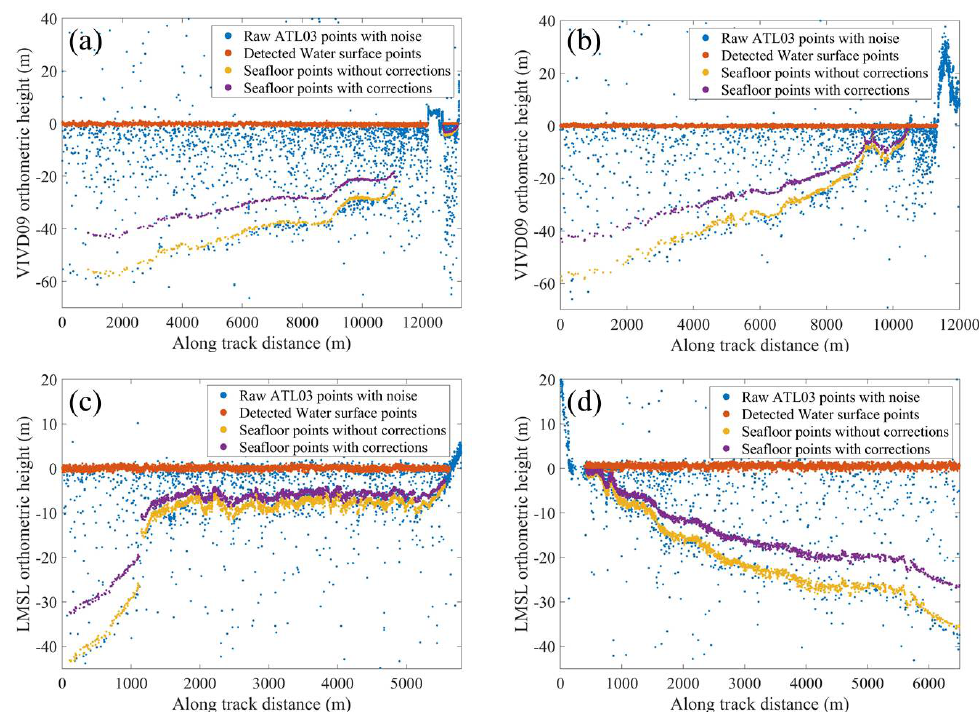
Figure 6. ICESat-2 along-track signal points after bathymetric corrections (not including the forward-scattering correction) in two study areas. ( a , b ) correspond to St. Thomas, whereas ( c , d ) correspond to Hawaii. Note that the ICESat-2 points have been converted to VIVD09 orthometric heights (at St. Thomas) or LMSL heights (at Hawaii), which are identical to the local in situ data. The height values of ICESat-2 water surface points are close to 0 m in orthometric heights.